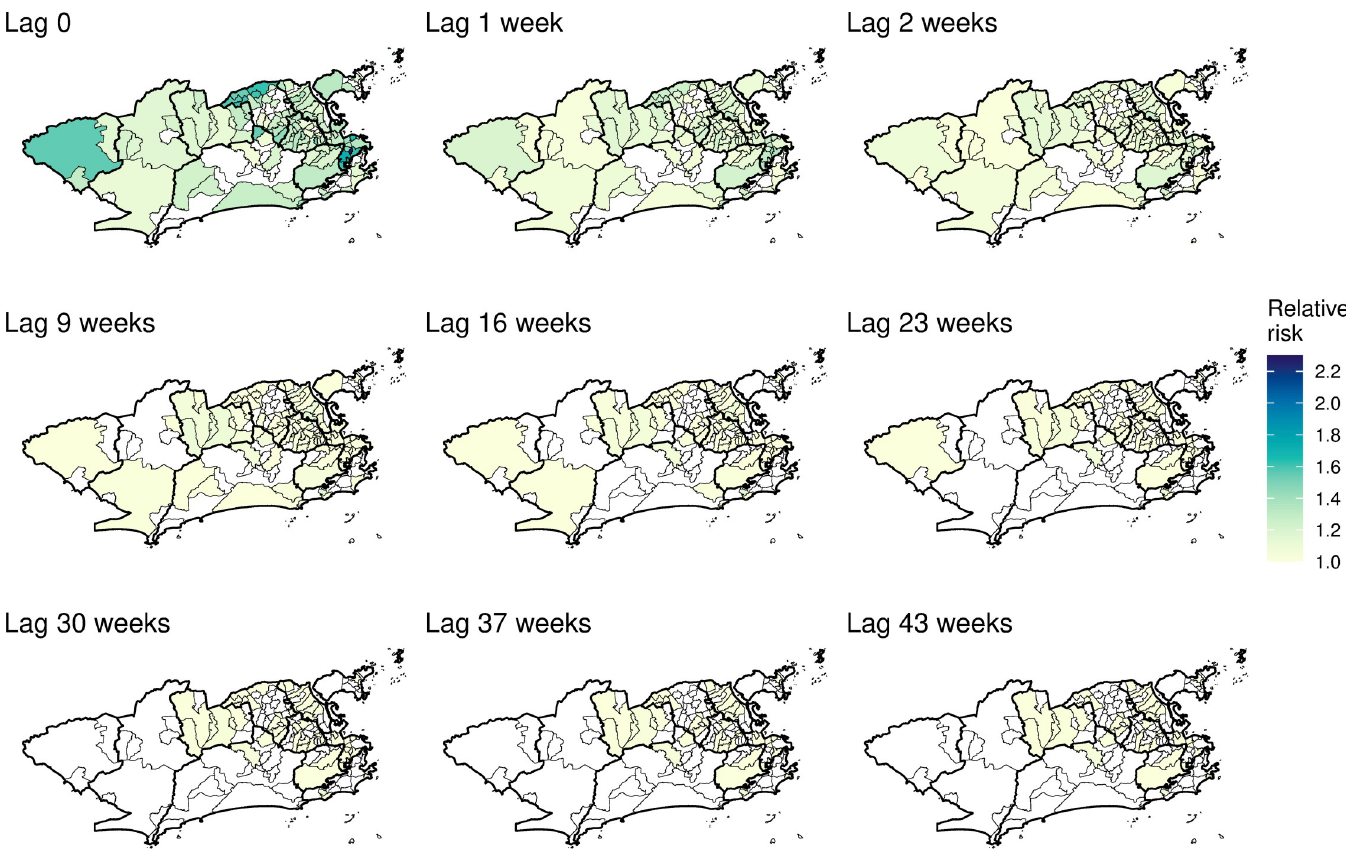
Fig 9. Minimum temperature instantaneous effect on chikungunya cases and its propagation in time by neighbourhood in selected weeks, controlling for sociodevelopment index and green areas proportion, and the latent spatial effect, Rio de Janeiro city, Brazil. Maps created using R version 3.6.1. Map layers by Instituto Pereira Passos